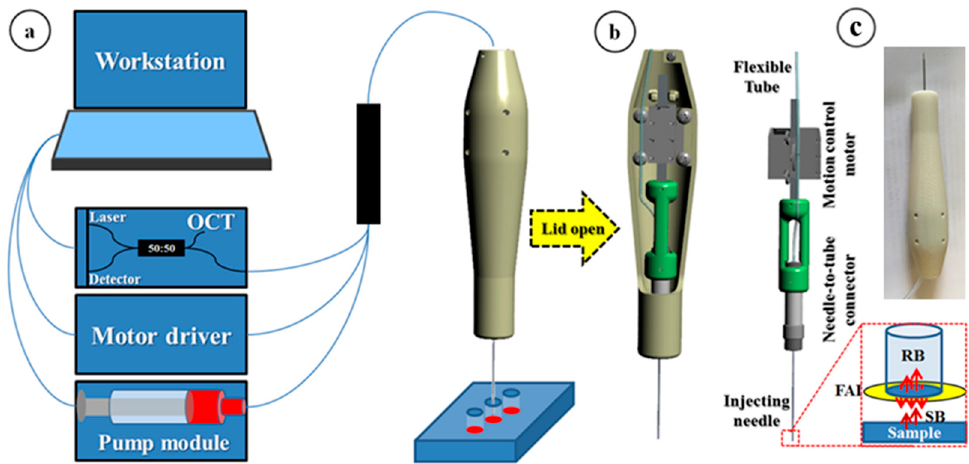
Figure 2. ( a ) System overview of the common-path swept source optical coherence tomography (CP-SSOCT) depth-guided microinjector; ( b ) internal structure of the microinjector and CP-SSOCT fiberoptic sensor: RB (reflected beam), FAI (Fiber-Air Interface), SB (sample reflected beam); and ( c ) picture of implemented injector handpiece.